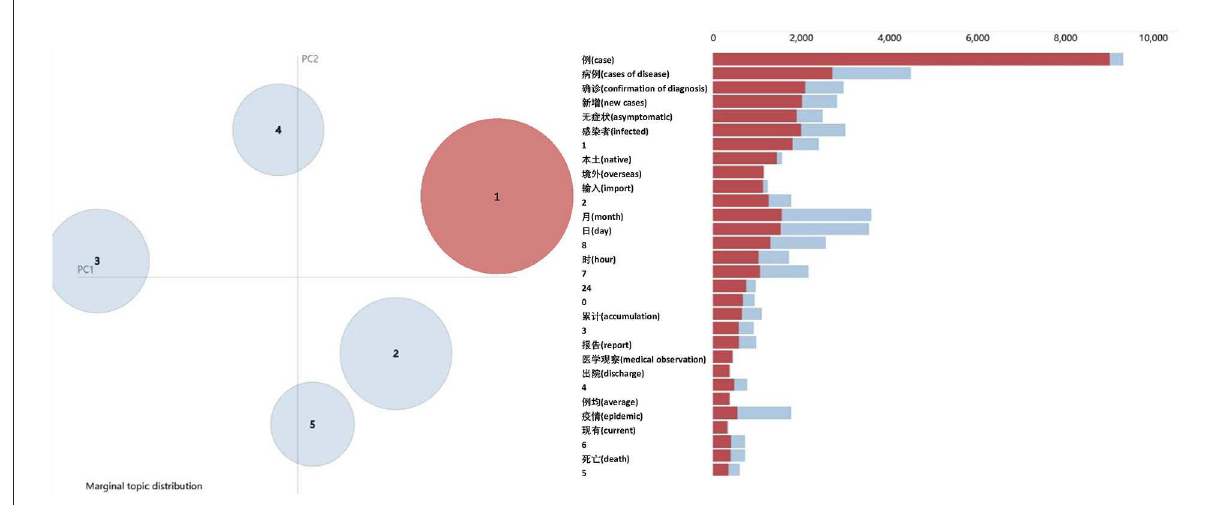
FIGURE8 The pyLDAvis visualization results for fear posts (topic number 5).